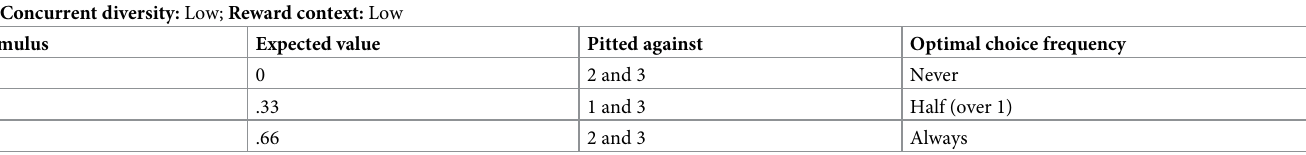
Table 1. Example image pairings in conditions of low and high concurrent diversity and reward